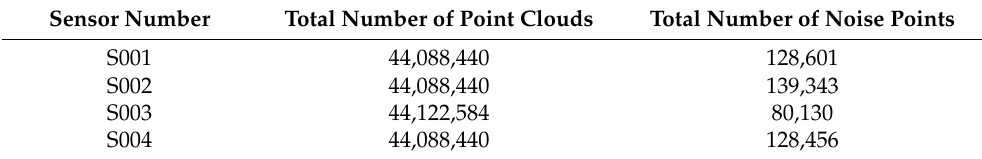
Table 2. Point number of point clouds.